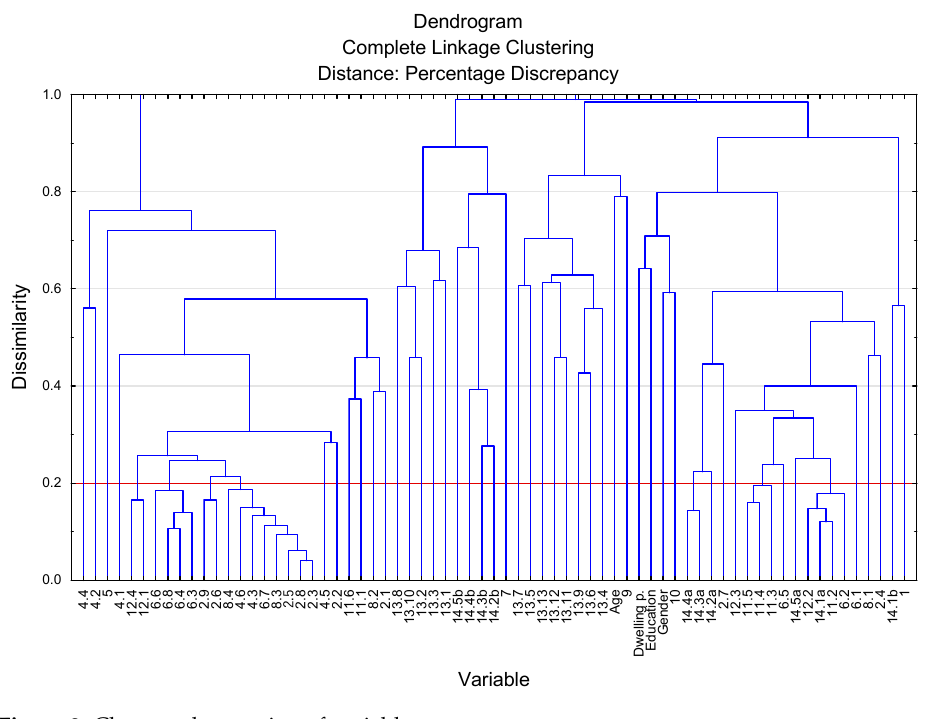
Figure 2. Chart agglomeration of variables.